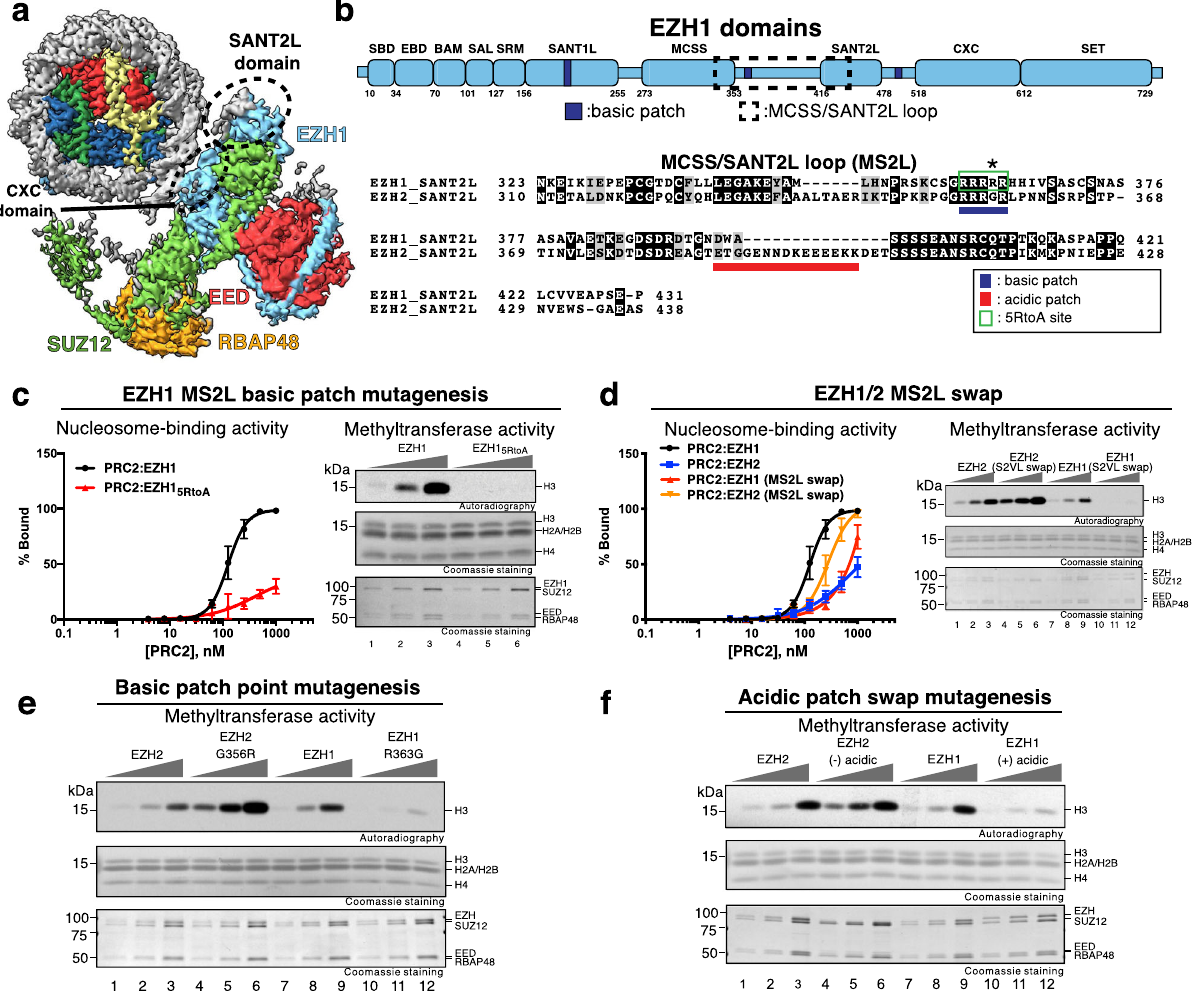
Fig. 2 The MCSS/SANT2L loop is important for PRC2 activity. a Composite map of one PRC2:EZH1 bound to nucleosome with regions that likely interact with DNA indicated by dashed circles. b Upper panel: Cartoon representation of EZH1 showing basic patches. Lower panel: Sequence alignment of EZH1 and EZH2 MCSS/SANT2L loops showing the basic patch (green box) and the acidic patch (red underline). c Nucleosome-binding and methyltransferase activities of PRC2:EZH1 containing fi ve arginine-to-alanine substitutions (see green box in panel b ). Experiments were done with core PRC2 containing SUZ12, EED, RBAP48, and wild-type or mutant versions of EZH1/2 as indicated. For graphs indicating nucleosome binding, each data point represents the average of three independent mobility-shift experiments and is shown as mean ± standard deviation. Methyltransferase assays measured the incorporation of 3 H-labeled S-adenosylmethionine into histone H3 at lysine 27. Assays were done in triplicate using 300 nM of nucleosomes and titration of 5 – 60 nM PRC2. d Experiments done as in panel c , except that regions aligned in panel b were “ swapped ” between EZH1 and EZH2. e Methyltransferase assay using reciprocal point mutation swaps between EZH1 and EZH2 (EZH1-R363G vs EZH2-G356R) (asterisk in panel b ). The experiment was done as in panel c . f Methyltransferase activity of PRC2 complexes with the acidic patch (see panel b ) deleted from EZH2 or inserted into EZH1 (residues 387 – 401 from EZH2 deleted or inserted into EZH1 between residues 394 and 395). The experiment was done as in panel c